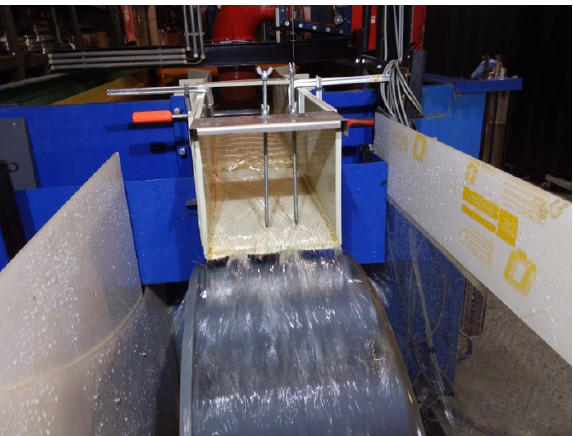
Fig. 1 . Supercritical flow in the